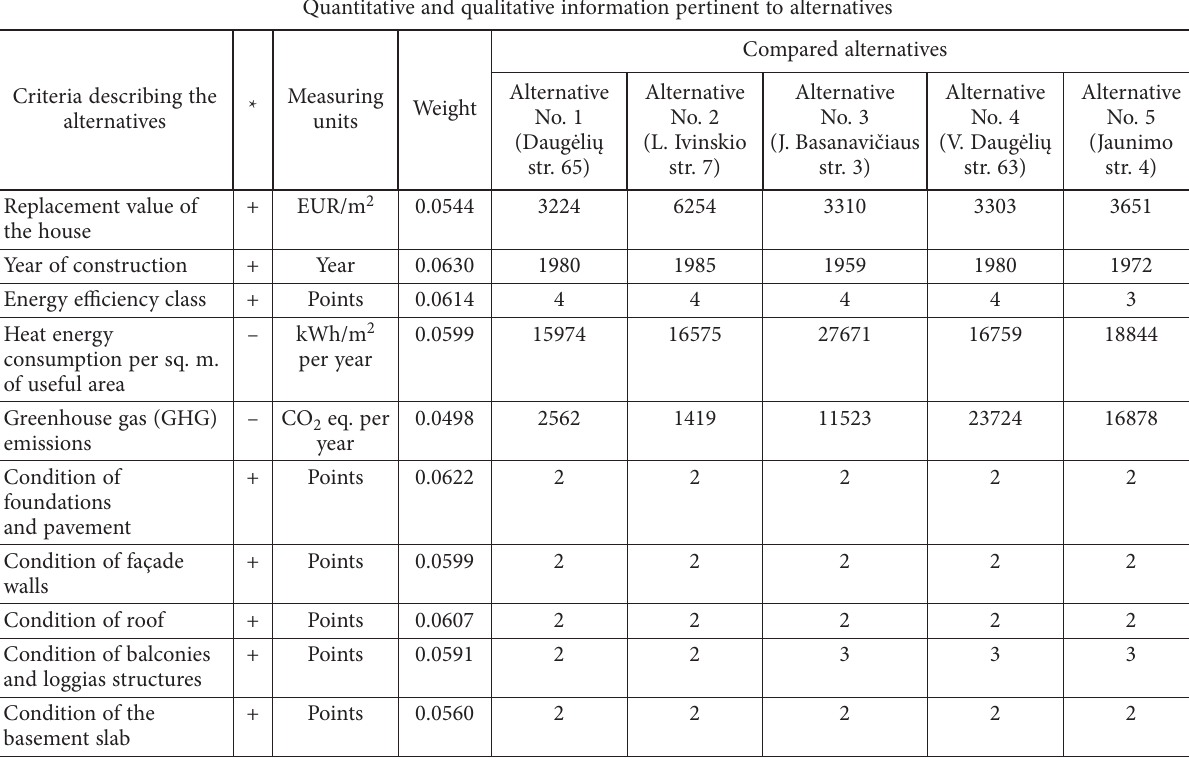
Table 3. Qualitative and quantitative description of the alternatives Quantitative and qualitative information pertinent to alternatives